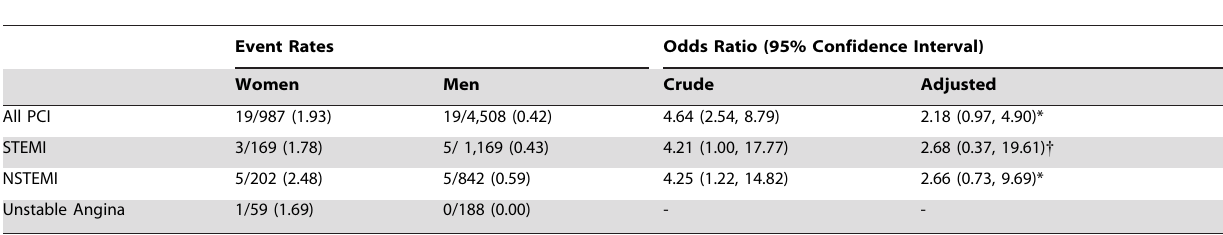
Table 10. Risk of mortality at 6 months for women compared to men.